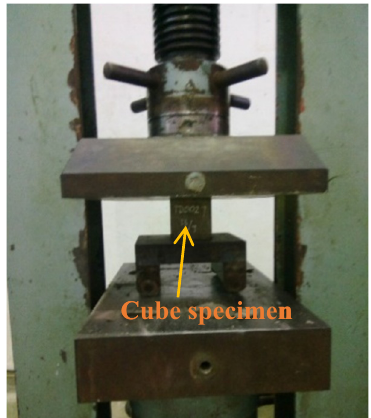
Figure 4: Compression test.